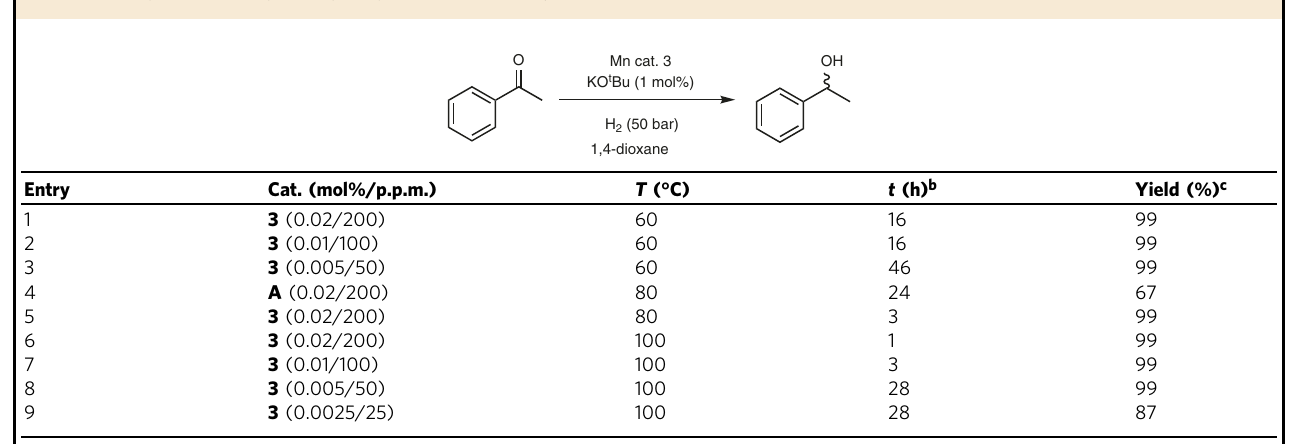
Table 1 Manganese-catalyzed hydrogenation of acetophenone a